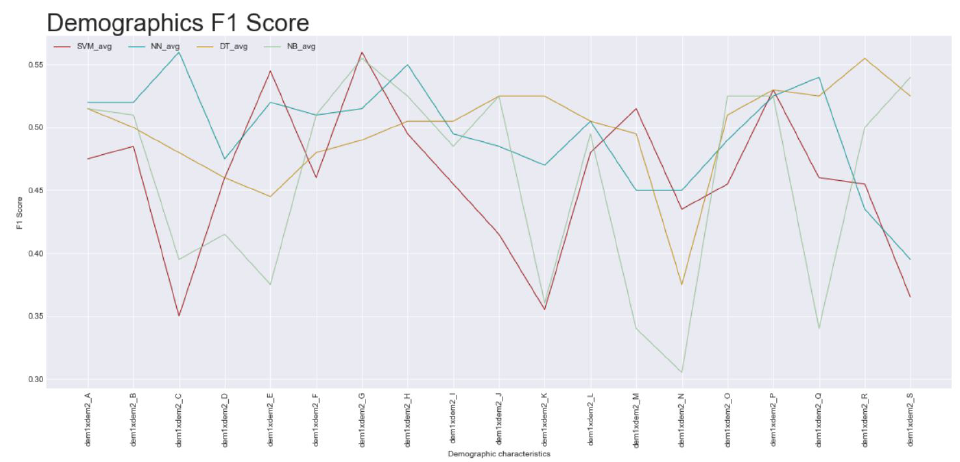
Figure 3. Variation of the F1 Score along the different tables related to variable dem1Xdem2 modelled and tested.